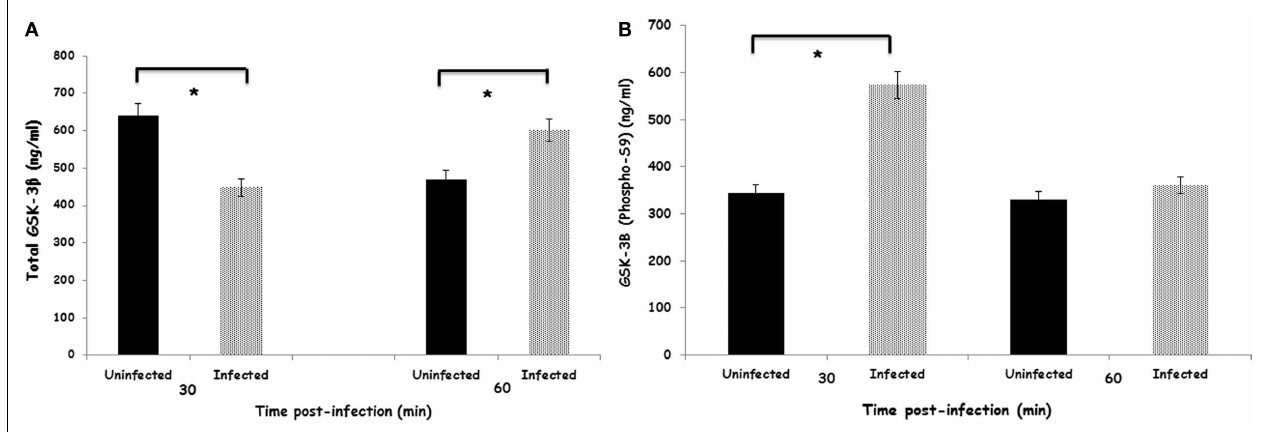
FIGURE 1 | Effect of S . Enteritidis infection on GSK-3 β activity in avian heterophils . (A) Total GSK-3 β activity in avian heterophils stimulated with S . Enteritidis or non-infected for 30 and 60min. (B) Phosphorylated-GSK-3 β